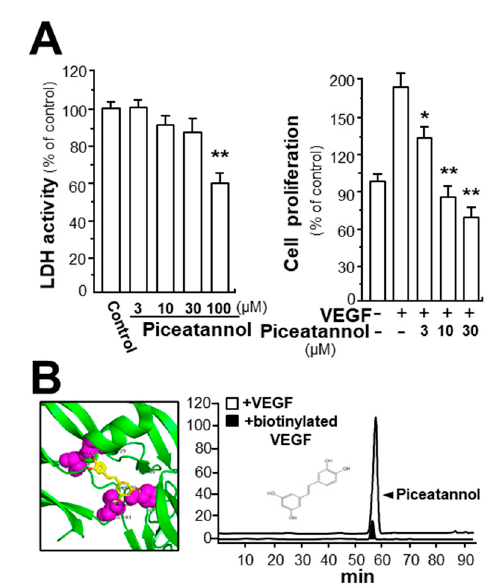
Figure 1. Piceatannol suppresses vascular endothelial growth factor A (VEGF)-induced cell proliferation and binding with VEGF. ( A ) Cultured endothelial cells (HUVECs) were incubated with a series of concentrations of piceatannol for 48 h and cytotoxicity detection kit plus (LDH) (left panel) and 3-(4,5-dimethylthiazol-2-yl)-2,5-diphenyltetrazolium bromide (MTT) (right panel) assays were performed. HUVECs, seeded into each well of a 96-well plate with cell density set at 5000 cells / well, were treated with piceatannol for 48 h in the presence or absence of VEGF (10 ng / mL). Data are in percentage of control group, as mean ± SEM, where n = 4; p < 0.05 (*); p < 0.01 (**) vs. VEGF-treated group; ( B ) Chemical structure of piceatannol and protein structure, for performing molecular auto-docking, were downloaded from NCBI-PubChem database and PDB, respectively. The interaction of piceatannol binding to VEGF was demonstrated. VEGF: green; piceatannol: sticks, color of carbon: yellow, oxygen: red, hydrogen: silver; the proposed binding site: purple (right panel). UPLC chromatogram was applied to determine the amount of piceatannol in supernatant after biotinylated VEGF or VEGF (100 ng / mL) in an immunoprecipitation assay by streptavidin magnetic beads, n = 3 (right